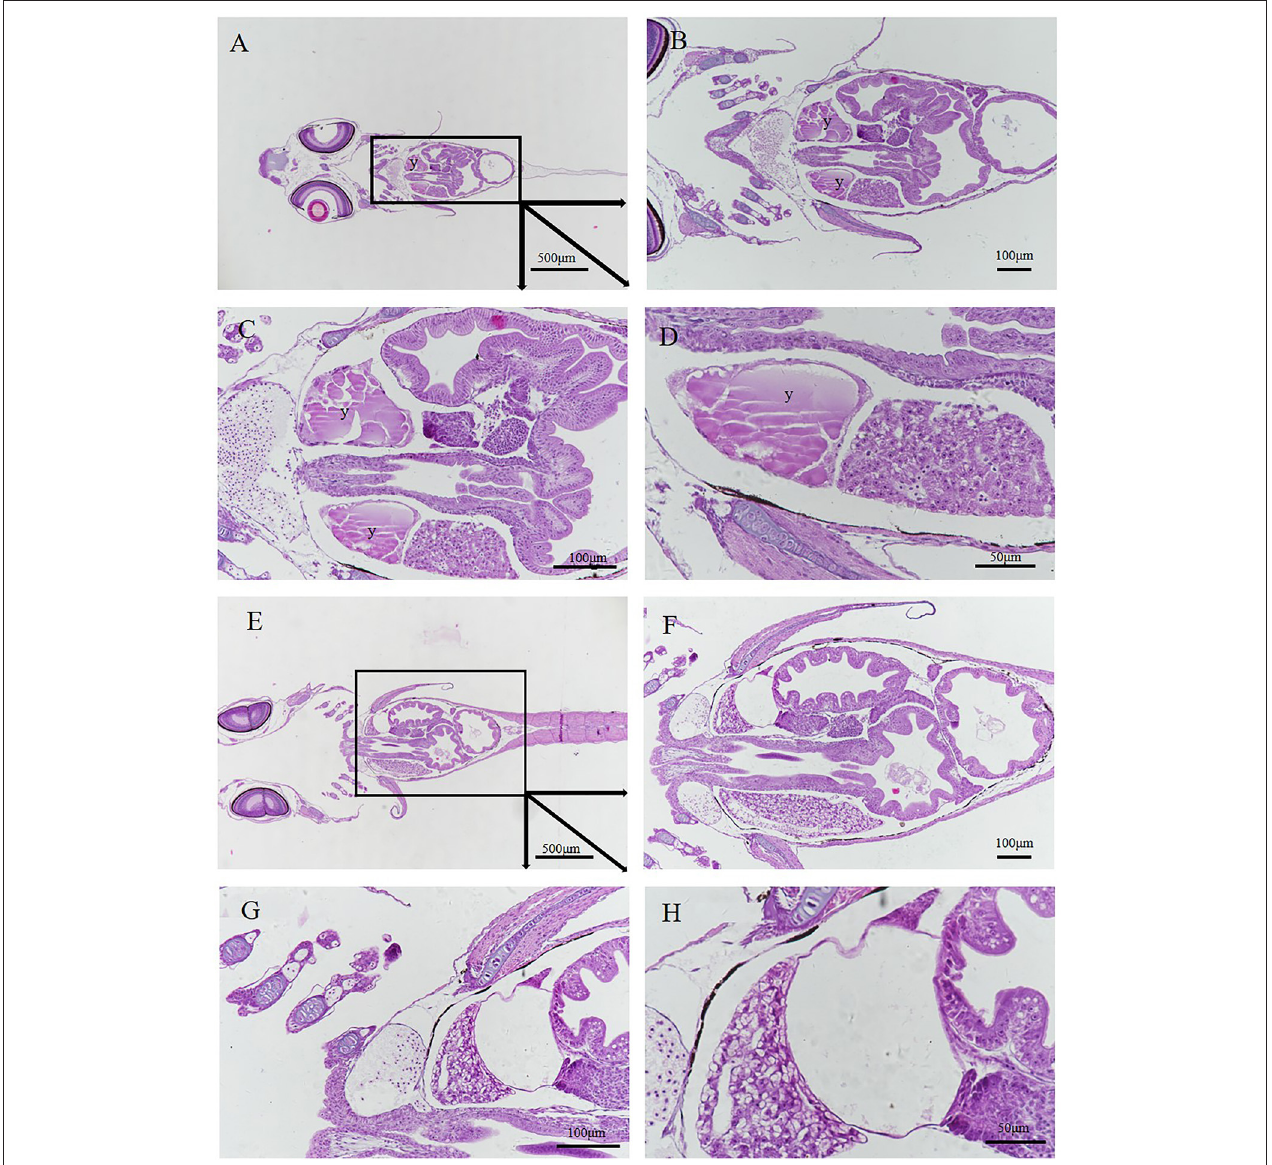
FIGURE 11 | Histology of postnatal larvae. (A–D) Larva 1 day after delivery with a small yolk (y) (E–H) 3rd day larva after delivery without yolk. Different parts were obtained by continuous sectioning. Scale bars, 500 µ m (A) ; 100 µ m (B,C,F,G) ; 50 µ m (D,H) . HandE stained.